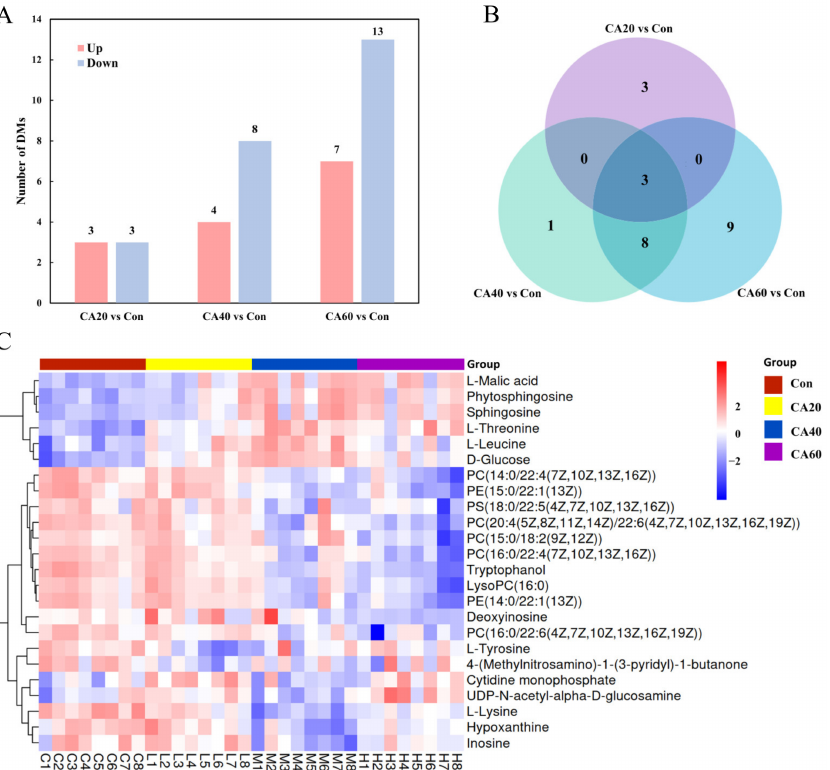
Figure 5. Differential metabolites of crucian carp kidney under different concentrations of carbonate alkali exposure. ( A ) Number of DMs. ( B ) Venn diagram of DMs. ( C ) Cluster heatmap of DMs. Con represents the freshwater control group, CA20 represents the 20 mmol/L NaHCO 3 exposure group, CA40 represents the 40 mmol/L NaHCO 3 exposure group, and CA60 represents the 60 mmol/L NaHCO 3 exposure group.